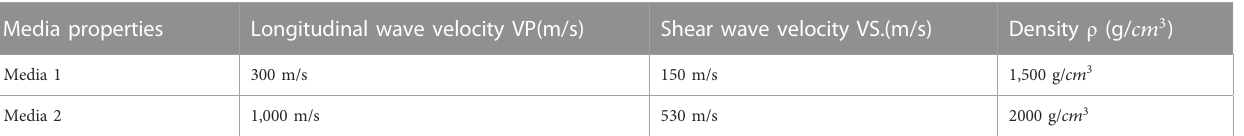
TABLE 1 Elastic parameters of